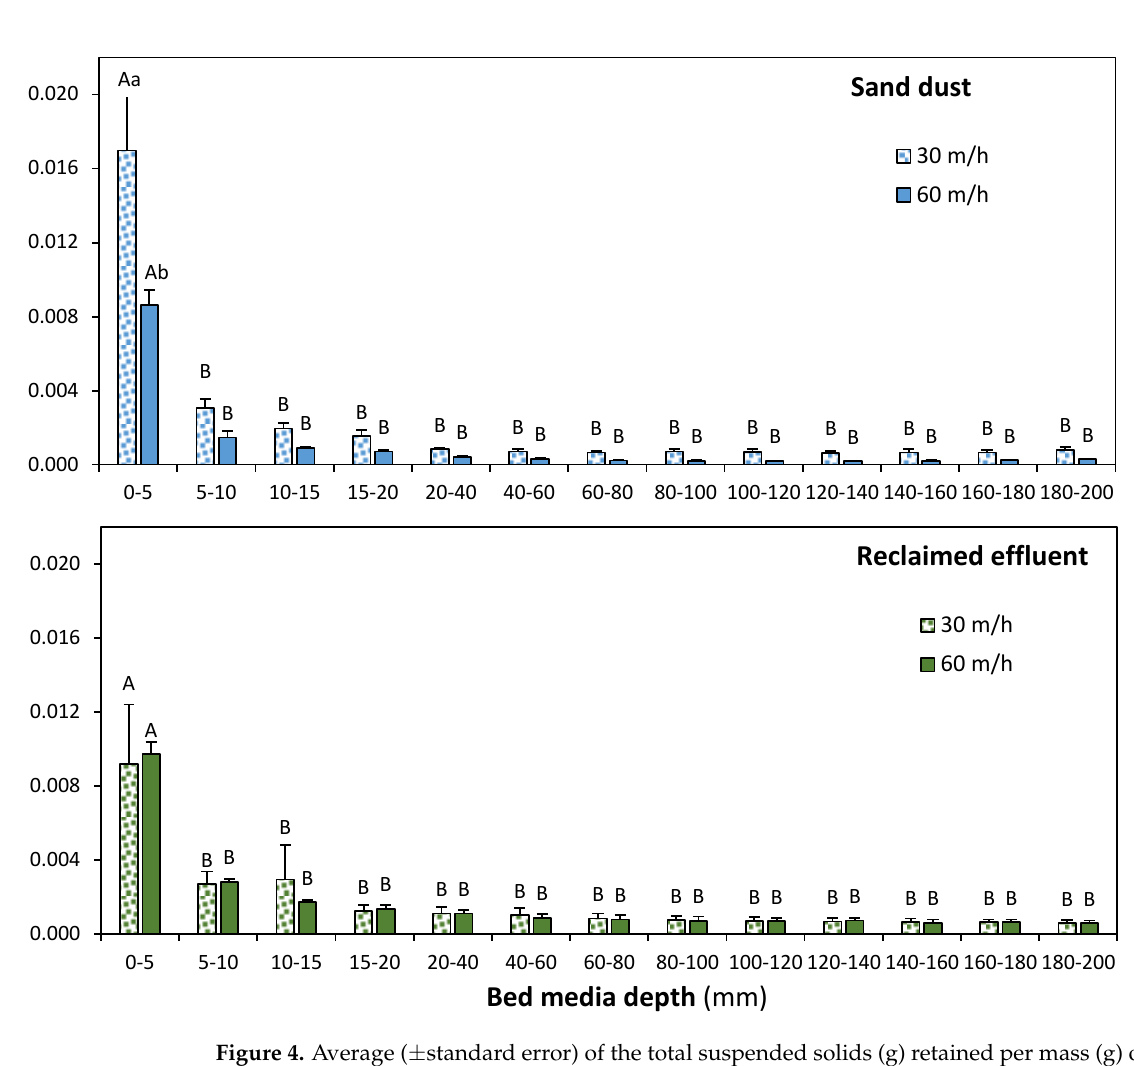
Table 4. Significance levels ( p -value) of the statistical model, each factor (filtration velocity, type of particle, and bed depth slice) and the double and triple interactions for explaining the percentage of the total suspended solids retained in each slice.